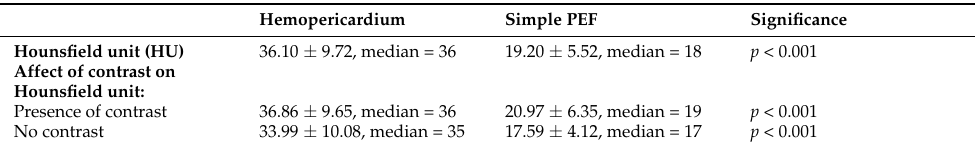
Table 5. Using Hounsfield units for the classification of hemopericardium or simple PEF, and the effect of contrast on the classification.